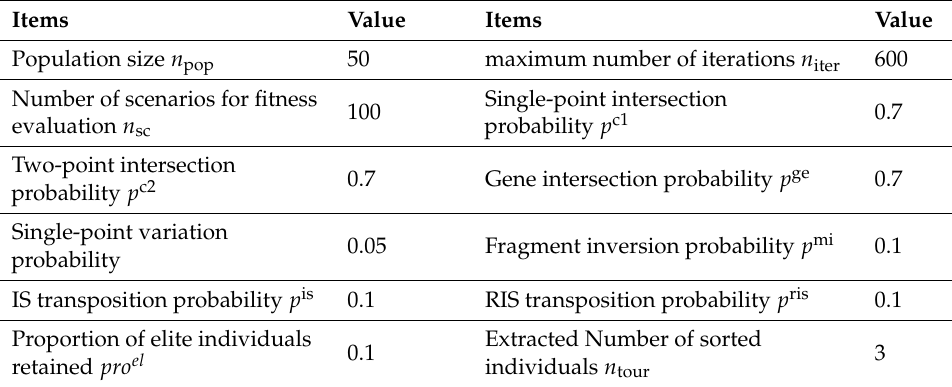
Table 6. The parameter settings of the evolution.